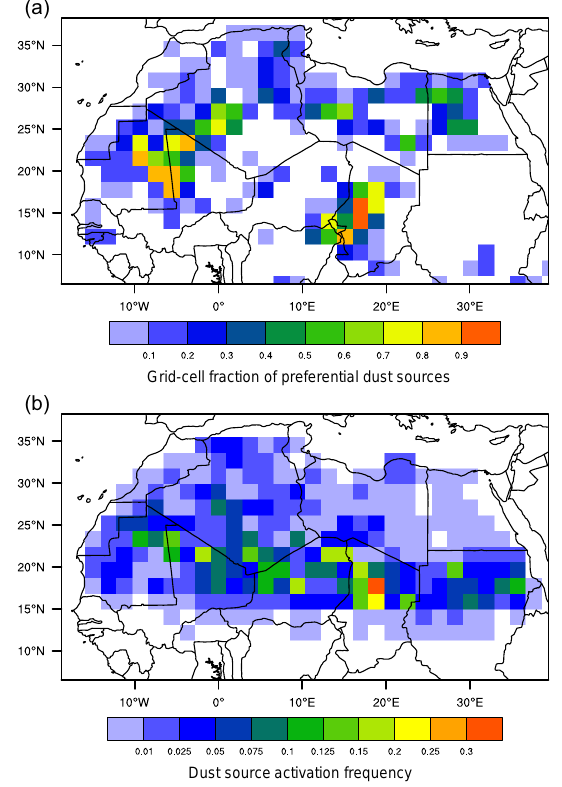
Figure 1. Preferential dust sources in the Sahara on a 1.875 ◦ × 1.875 ◦ (T63) grid. (a) Grid-cell fraction covered by pref- erential dust sources calculated from the extent of potential lake areas (Tegen et al., 2002) and (b) dust source activation frequen- cies derived from the 15min MSG-SEVIRI IR dust index for March 2006 to February 2010 (Schepanski et al., 2007,